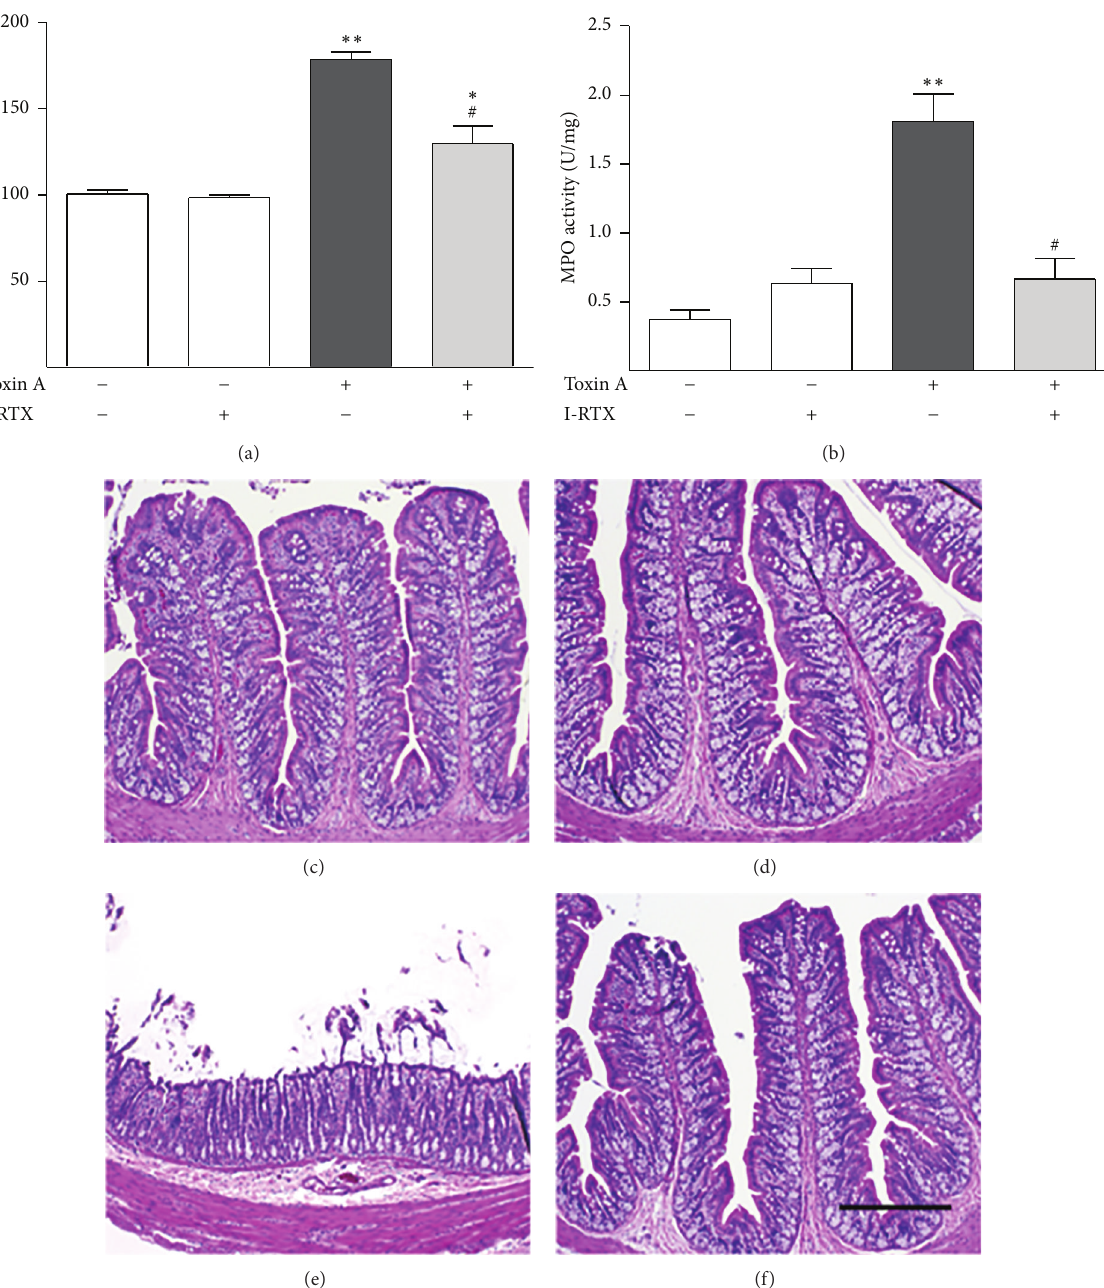
Figure 1: Effects of toxin A on colonic luminal fluid accumulation, MPO activity, and histopathology and inhibition of these effects by TRPV1 antagonism. (a) Toxin A-induced stimulation of colonic luminal fluid accumulation and the inhibition of this effect by pretreatment with 1 𝜇 g of I-RTX administered intraluminally 30 min before toxin A. (b) Toxin A-induced stimulation of colonic MPO activity and the inhibition of this effect by pretreatment with 1 𝜇 g of I-RTX administered intraluminally 30 min before toxin A. H&E-stained sections of rat colonic segments after they were treated intraluminally for 3 h with vehicle (c), 1 𝜇 g of I-RTX (d), 5 𝜇 g of toxin A (e), or 5 𝜇 g of toxin A after pretreatment with 1 𝜇 g of I-RTX 30 min before toxin A administration (f). Scale bar, 100 𝜇 m. ∗ 𝑃 < 0.05 versus toxin A( − )/I-RTX( − ); ∗∗ 𝑃 < 0.001 versus toxin A( − )/I-RTX( − ); # 𝑃 < 0.05 versus toxin A(+)/I-RTX( − ).